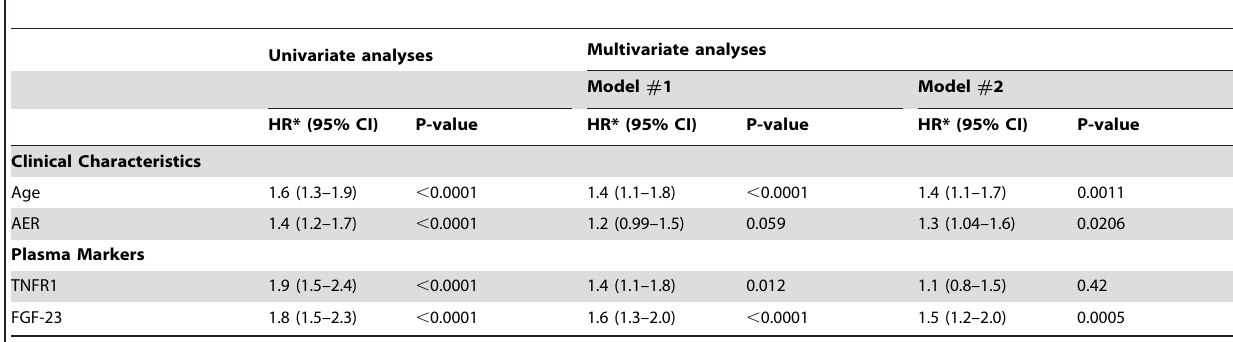
Table 4. Univariate and multivariate Cox proportional hazard models assessing risk of all-cause mortality adjusting for relevant baseline clinical characteristics and plasma markers in subjects with T2D followed for 8–12